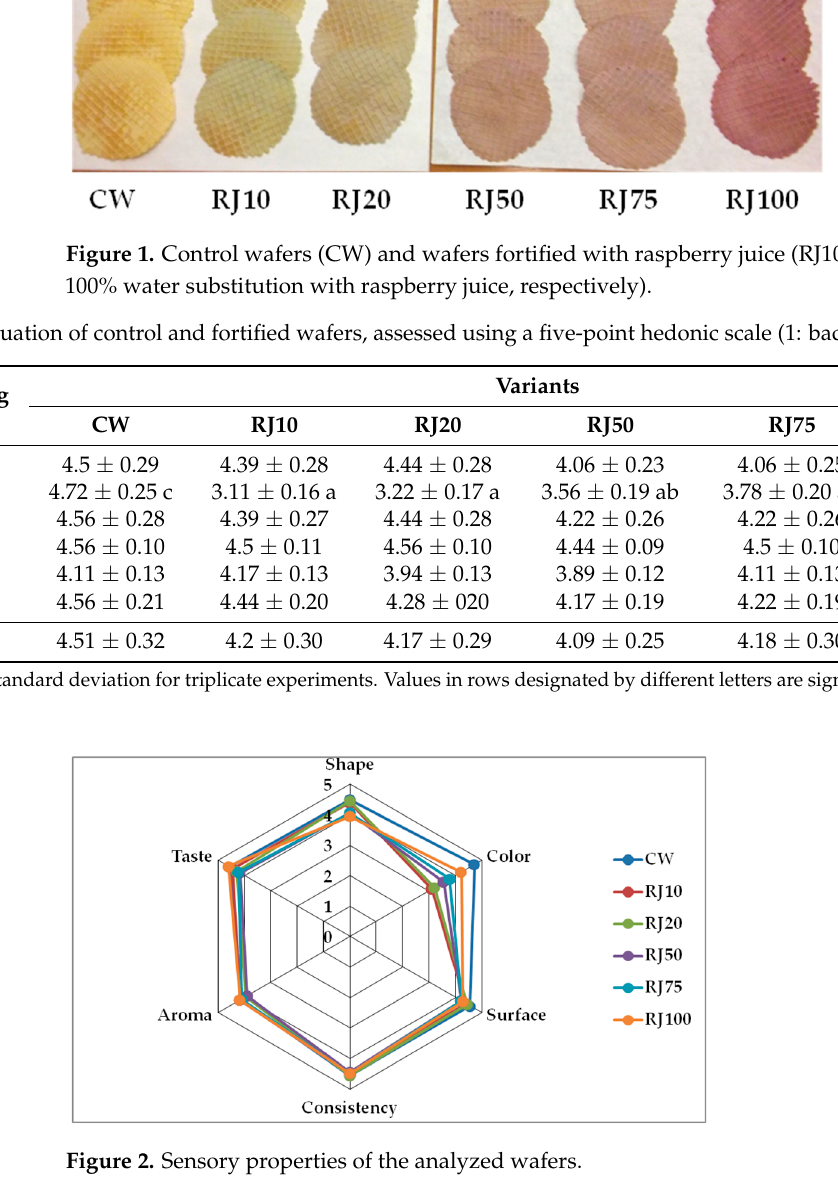
Figure 2. Sensory properties of the analyzed wafers. Table 2. Sensory evaluation of control and fortified wafers, assessed using a five-point hedonic scale (1: bad; 5: very good). Quality